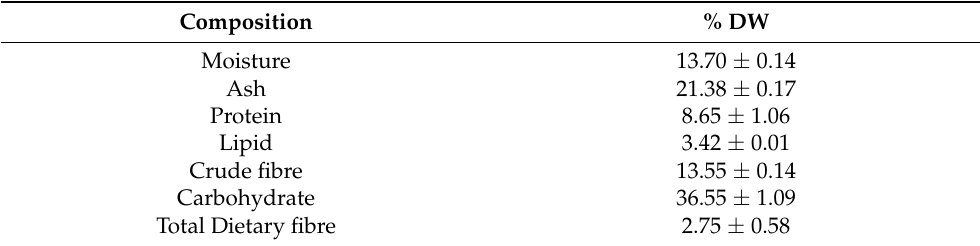
Table 1. Proximate composition of ground lyophilised S. polycystum